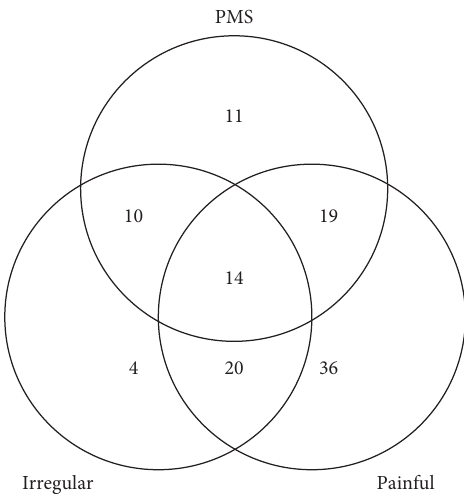
Figure 1: The number of women in each type of disorders.